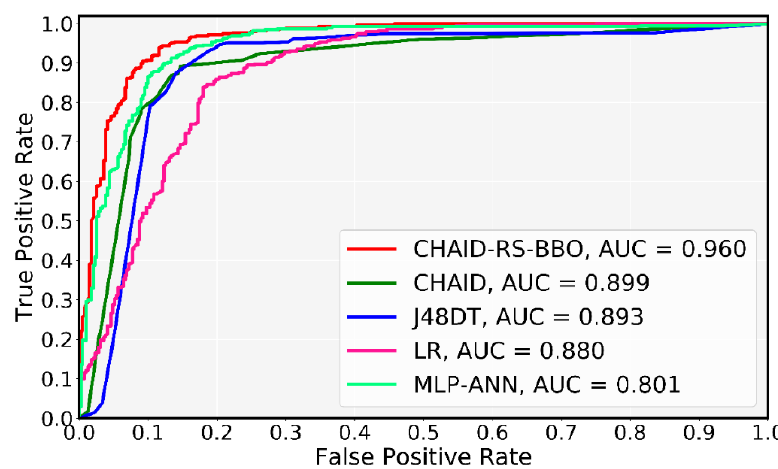
Figure 7. The ROC curve of the five flash flood models in the validating phase.